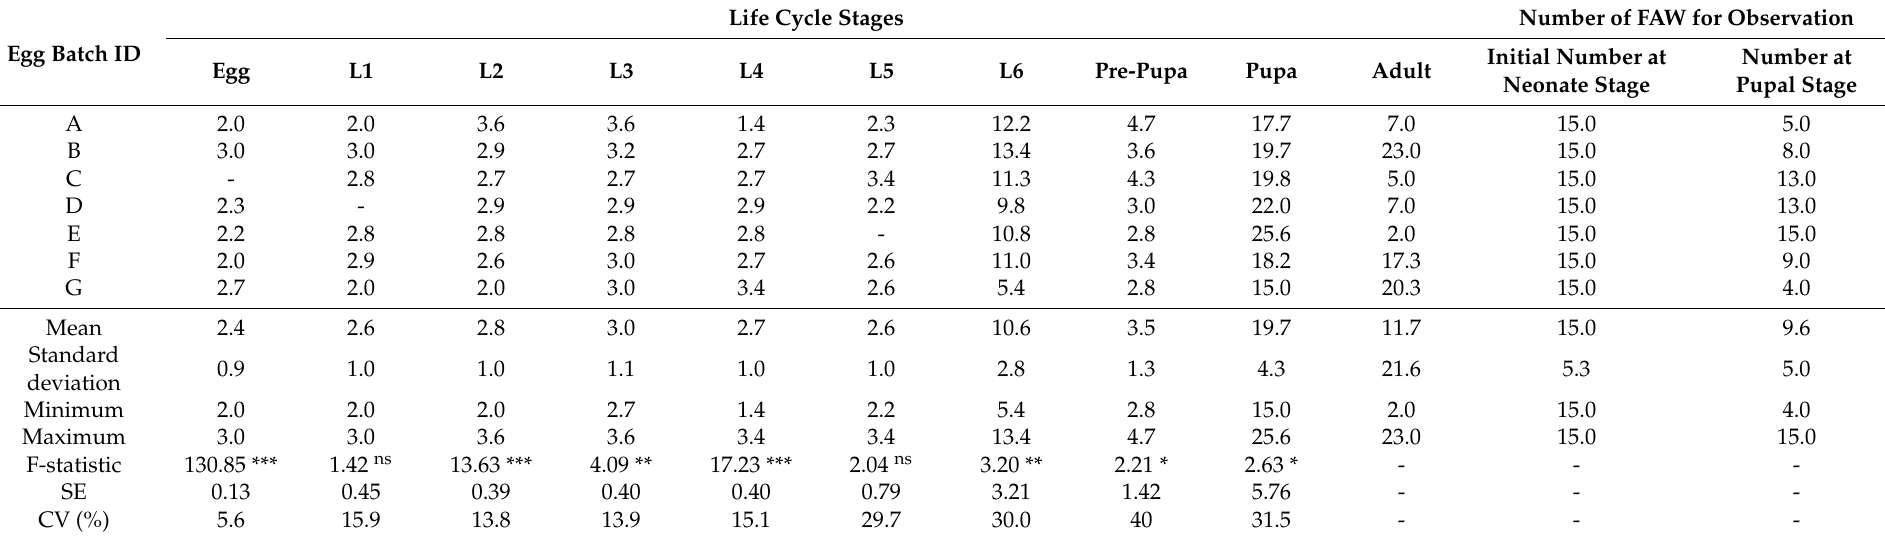
Table 5. Observed durations of FAW life cycle stages under laboratory